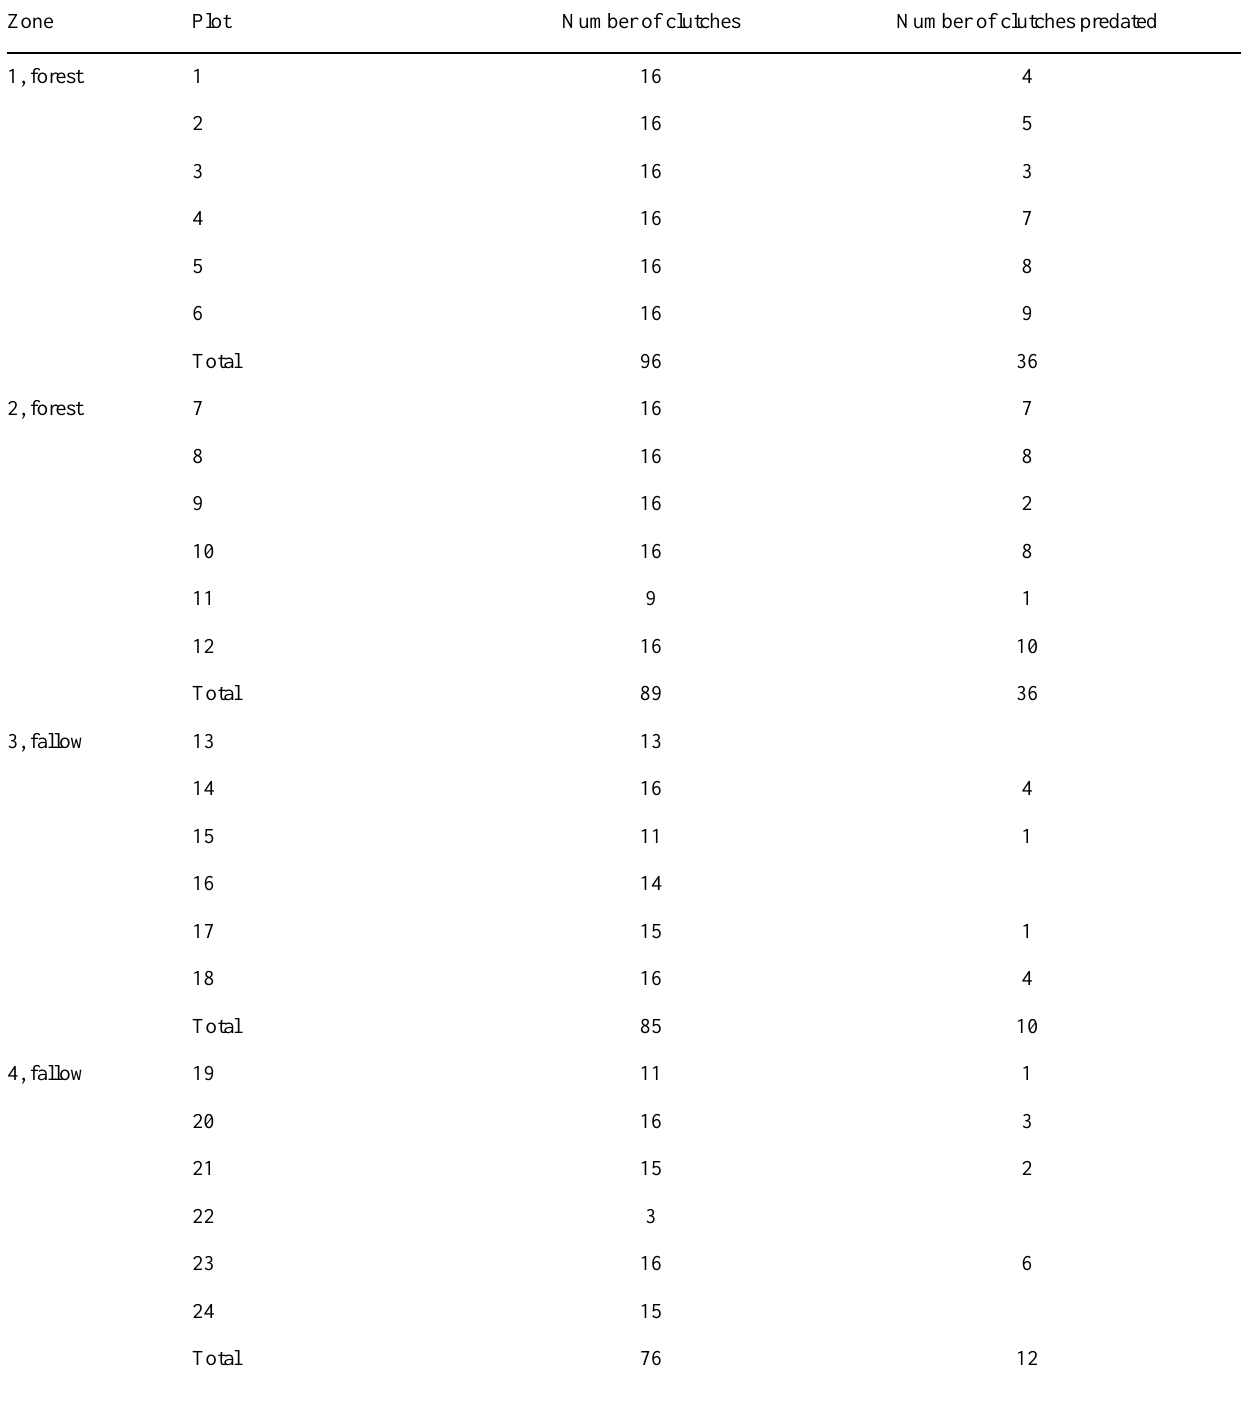
Table 3. Numbers of clutches placed in 24 plots in four zones and predated after 2 wk.